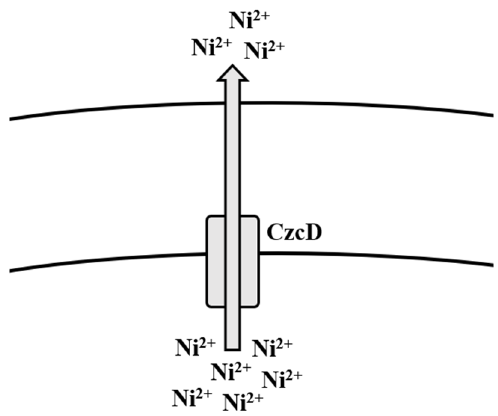
Figure 3 . Efflux mechanism of nickel in Bacillus spp. Figure 3. Efflux mechanism of nickel in Bacillus